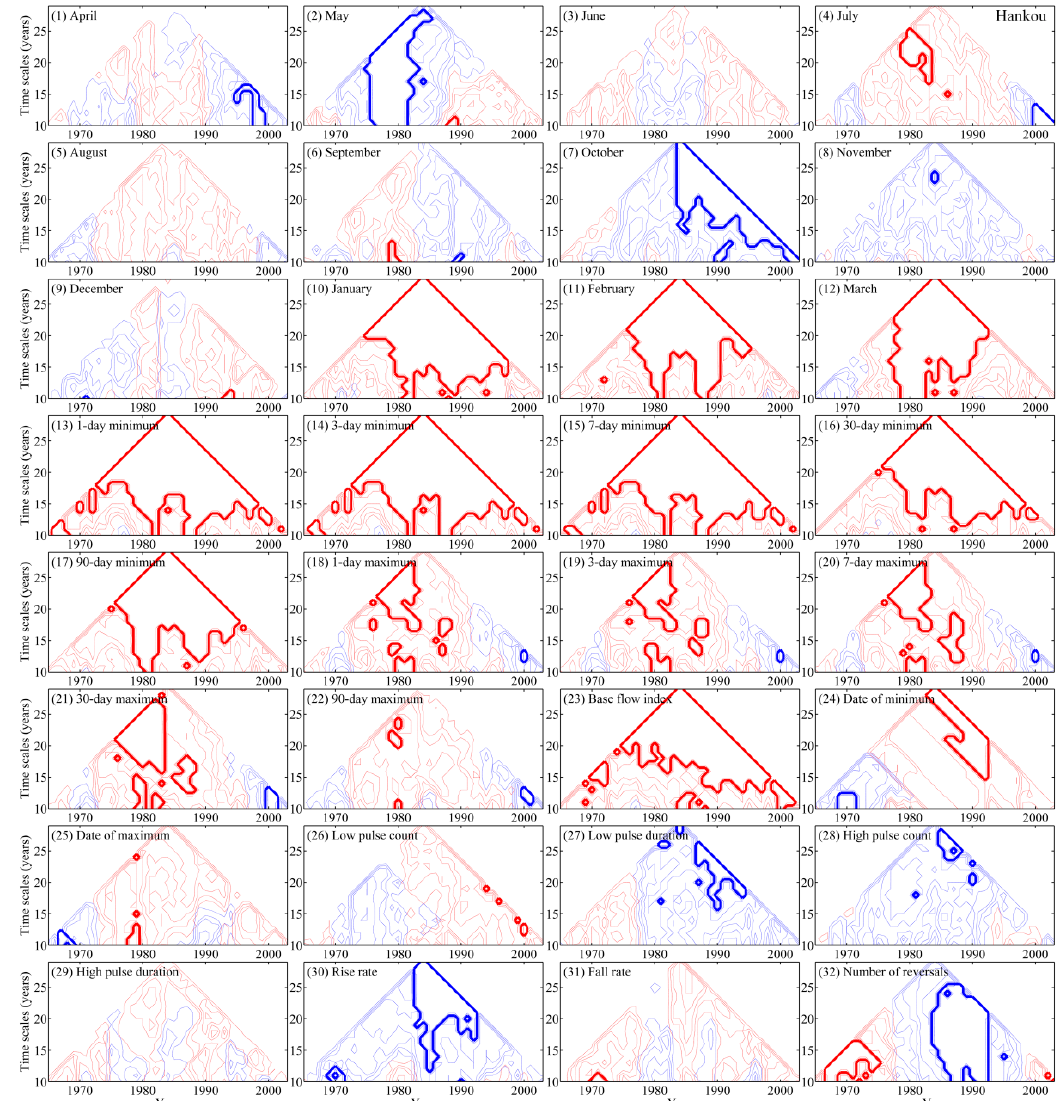
Figure 10. Change points on different time scales of the hydrologic regime at the Hankou station.